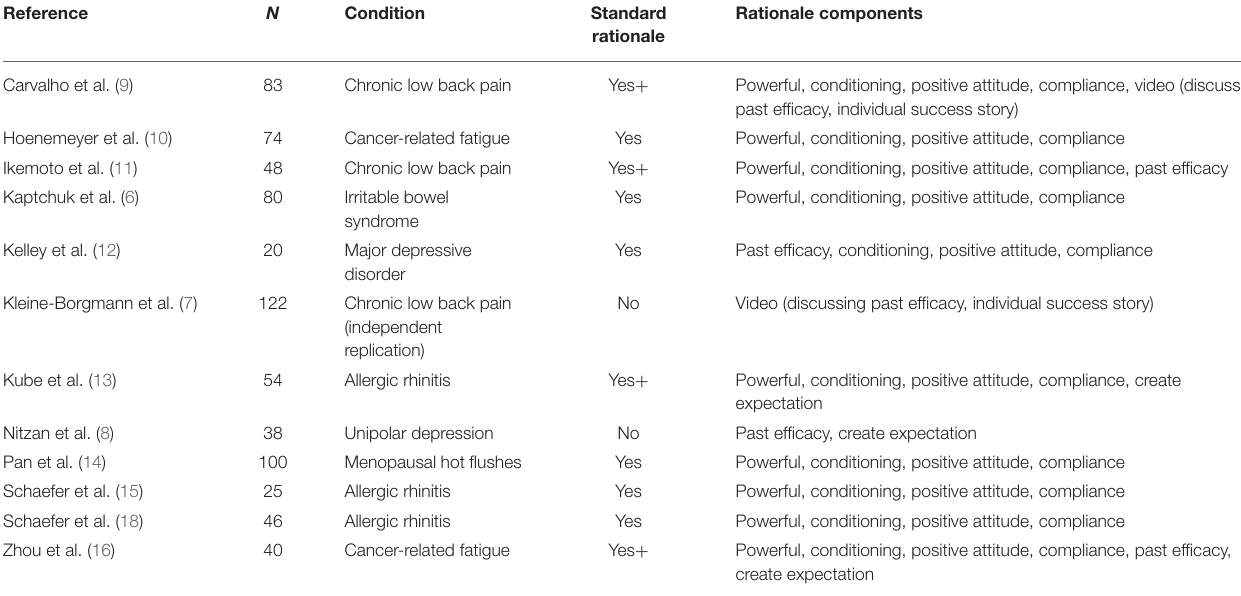
TABLE 1 | Overview of placebo rationales in OLP studies with clinical